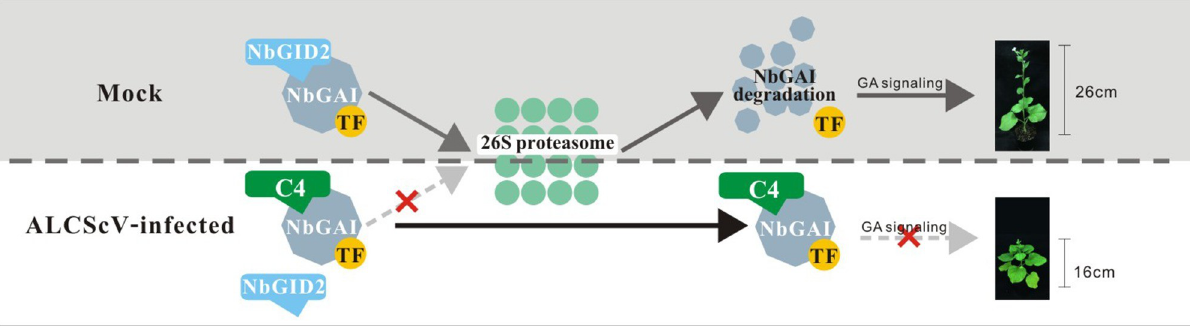
Fig 11. Proposed model. In mock N . benthamiana plants, the interaction between NbGAI and NbGID2 leads to the ubiquitination and degradation of NbGAI by the 26S proteasome, releasing specific transcription factors. Then, genes of the gibberellin (GA) signaling pathway are adequately regulated by corresponding transcription factors, promoting normal growth of N . benthamiana plants. Under ALCScV infection conditions, C4 directly interacts with NbGAI, which interferes with the interaction between NbGAI and NbGID2 to prevent the degradation of NbGAI and block the GA signaling pathway, ultimately leading to symptoms of plant dwarfing and abnormal flower